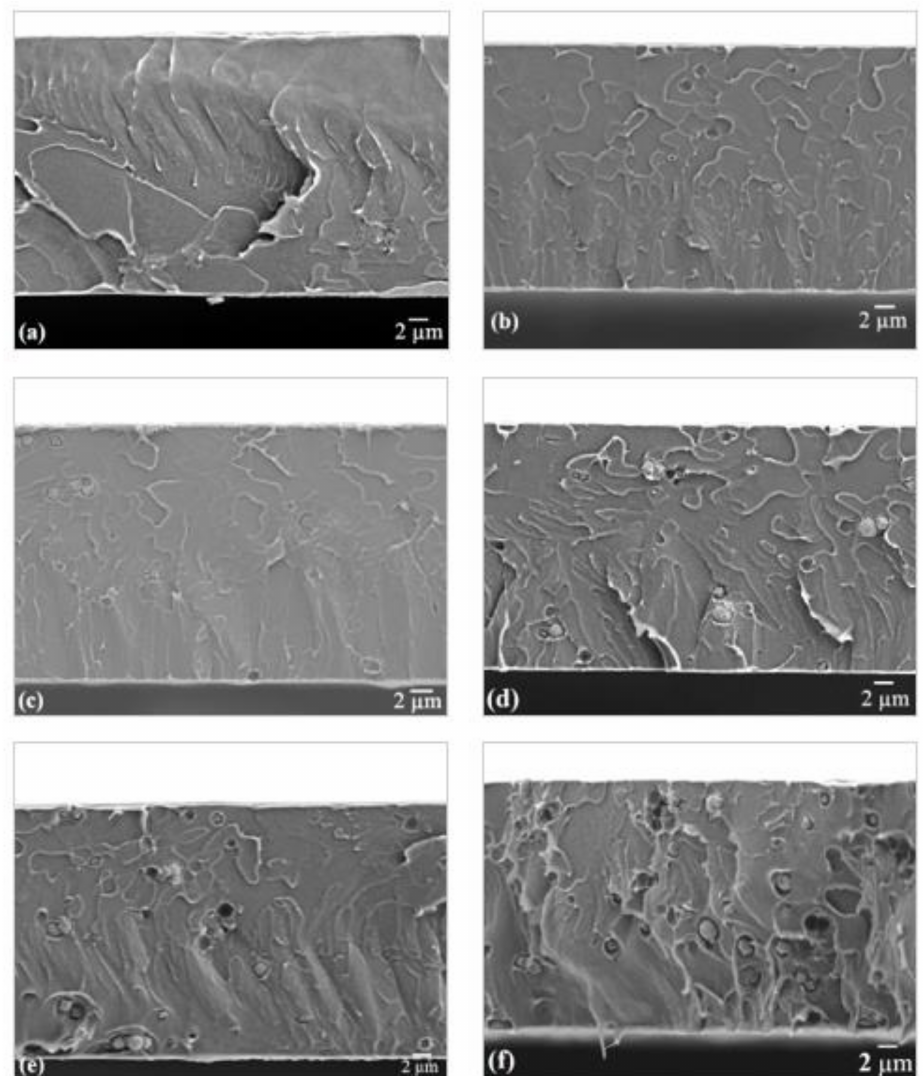
Figure 10. Cross sectional FESEM images of ( a ) pristine PSf membrane, ( b ) 1RHO/PSf, ( c ) 2RHO/PSf, ( d ) 3RHO/PSf, ( e ) 4RHO/PSf, and ( f ) 5RHO/PSf